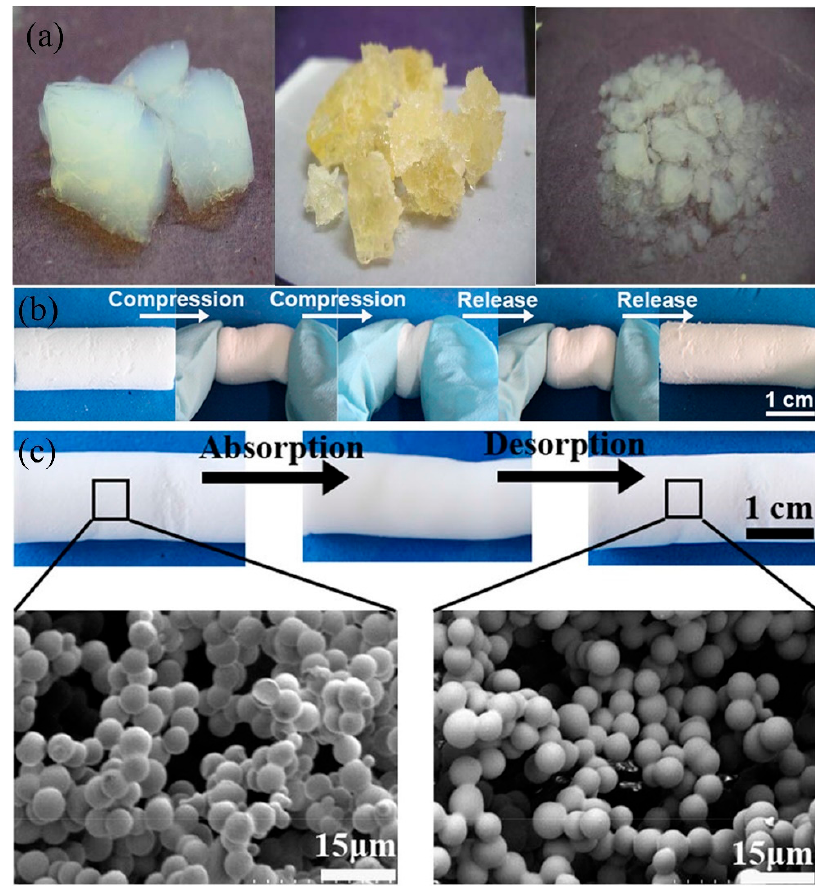
Figure 12. ( a ) Photographs of the various stages of tetraethoxysilane (TEOS) aerogel, before absorption (left), during desorption (middle and right) [185]. ( b ) Photograph of the compression/recovery process of the dimethyldiethoxylsilane–methyltriethoxysilane (DMDES–MTMS) aerogel. ( c ) SEM images of the adsorption (before) and the desorption (after) of aerogel [137]; reproduced with permission from Springer.